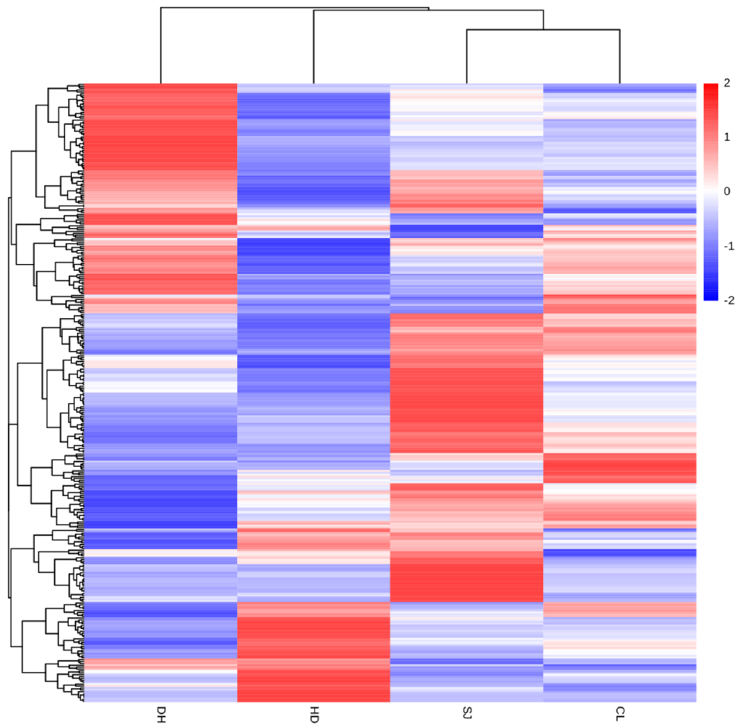
Figure 3. Heatmap of cluster analysis of differential metabolites in four rice samples (Daohuaxiang (DH), Huaidao No. 5 (HD), Songjing (SJ), and Changlixiang (CL)).